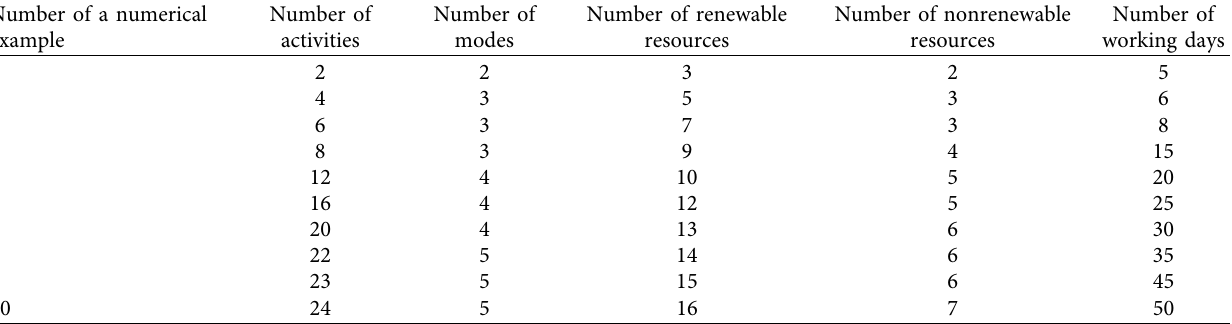
Table 2: Numerical examples in different